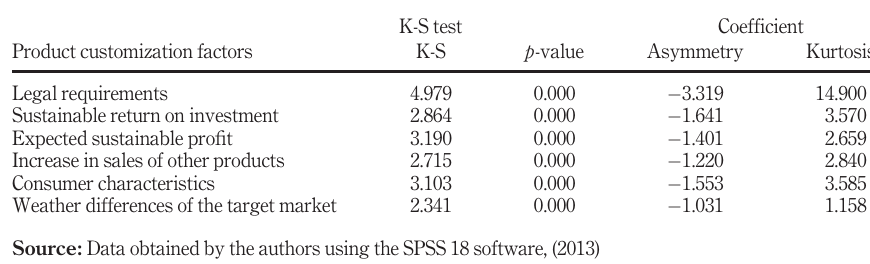
Table III. K-S test for a sample of 123